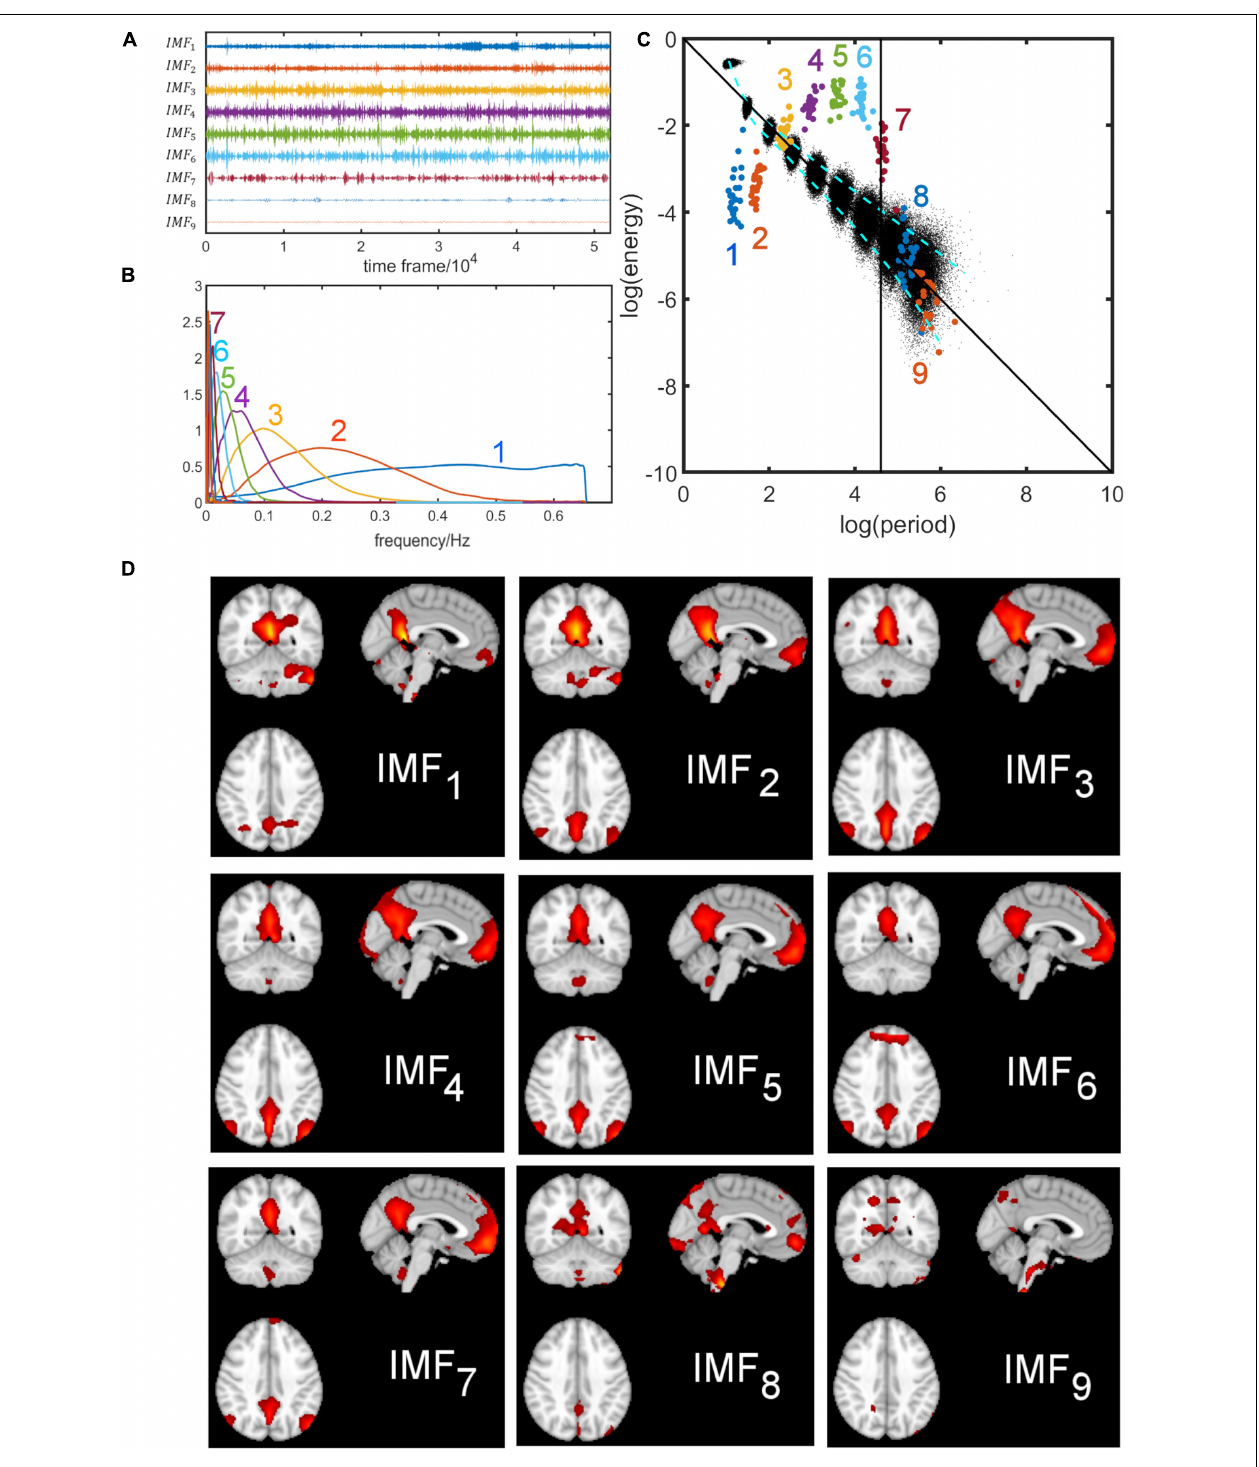
FIGURE 4 | Decomposition of the default mode network (DMN) using empirical mode decomposition. The time courses for all subjects were concatenated. Top left figure (A) shows the first nine intrinsic mode functions (IMFs). The corresponding frequency distributions are shown in figure (B) . IMF 1 has a wide high-frequency spectrum whereas the higher-order IMFs have a narrow-band low-frequency spectrum. The figure on the top right (C) shows the energy-period relationship of the IMFs of the DMN superimposed on the white noise spectrum (black dots). Each colored dot represents a subject. The black vertical line corresponds to the drift-frequency cut-off of 0.01 Hz. Information to the right of this line correspond to scanner-related artifacts and is of no interest in this study. In the bottom figure (D) , the spatial components associated with each IMF are shown. The DMN is seen more clearly in IMFs 2–7 than in IMFs 1,8,9.